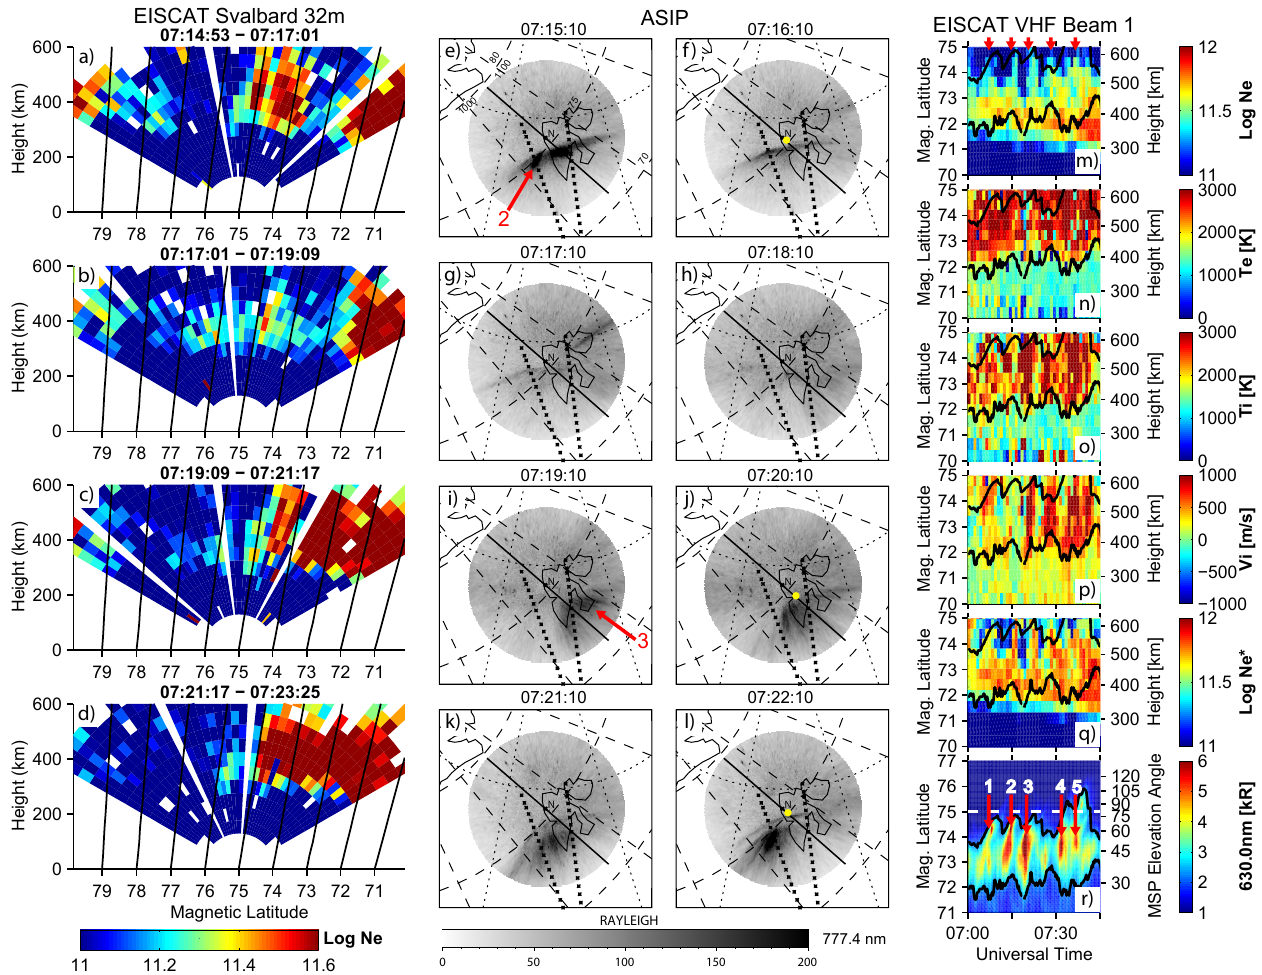
Fig. 2. The upper left panel (a) shows ESR measurements of the cusp plasma boundary just above 72 ◦ and the previously injected patch farther to the north. The next three panels (b–d) show the injection of the next patch. The central series of ASIP images (panels e–l ) show optical emissions marking the associated particle precipitation boundary that is surging poleward with the reconnection event. Both the electron density measurements (Log Ne) and the ASIP images show the speed with which the event boundaries move. The panels on the right show plasma properties from the EISCAT VHF radar that was looking over Svalbard (m–q) and meridian scanning photometer data from Ny- ˚Alesund (r) . These data show five successive patches that are created and injected across the cusp and into the polar cap. Further details are given in Carlson et al. (2006), which is the source of this